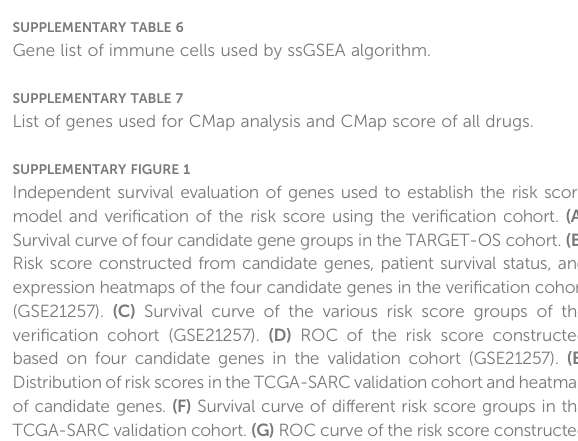
SUPPLEMENTARY TABLE 1 Clinical data for the entire cohort. SUPPLEMENTARY TABLE 2 Demographic information and clinical characteristics of the training and validation cohorts. SUPPLEMENTARY TABLE 3 Aging/senescence-induced genes. SUPPLEMENTARY TABLE 4 Details of the cellular biomarkers.